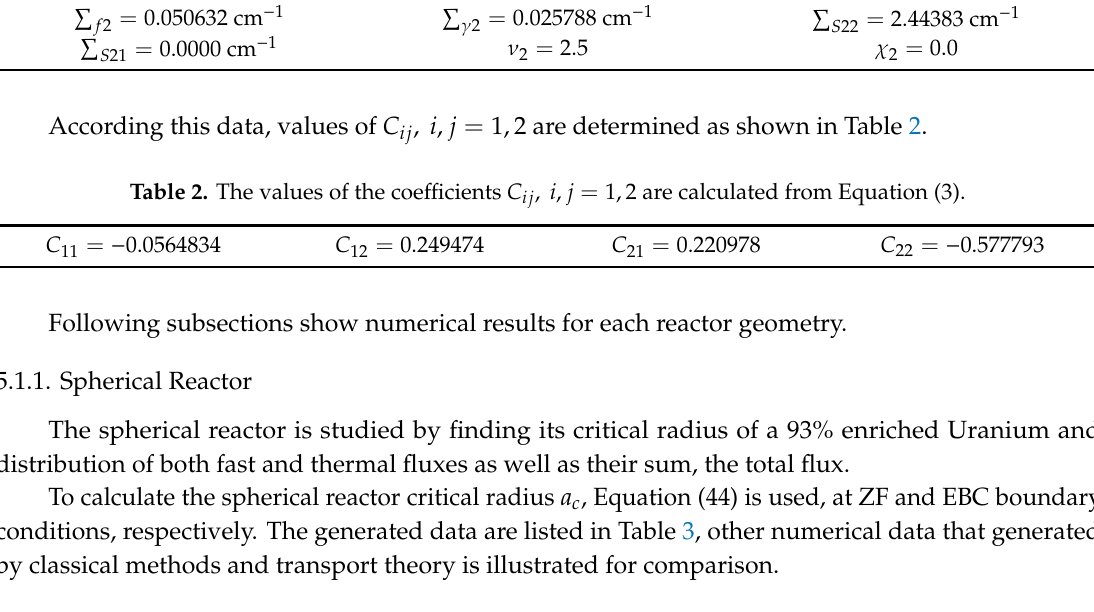
Table 3. The critical radius a c of a 93 % enriched Uranium spherical reactor.